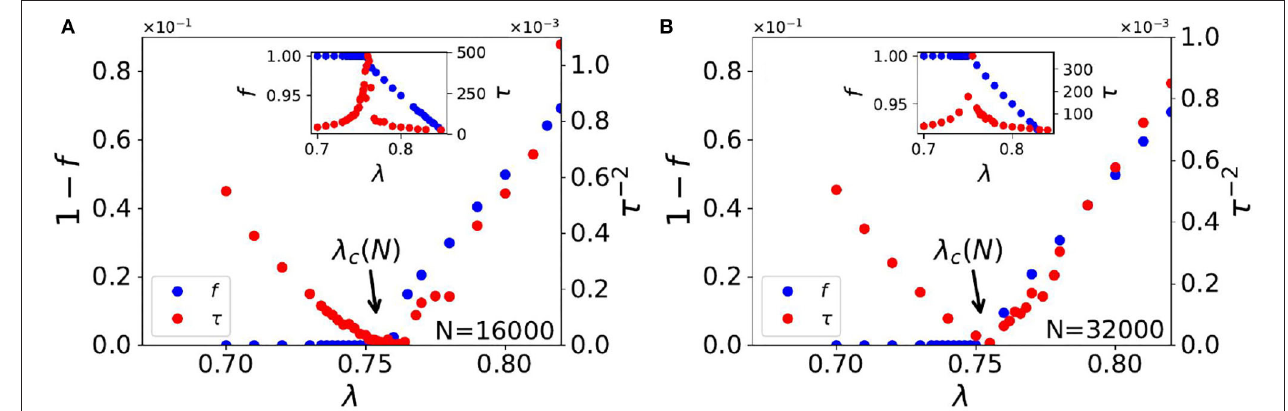
FIGURE 1 | Plots of steady state convergence behavior in infinite dimensional lattice; Social wastage fraction (1 fraction λ . Observed power laws are (1 of f and τ against λ , showing the diverging behavior of τ where f reaches unity at λ